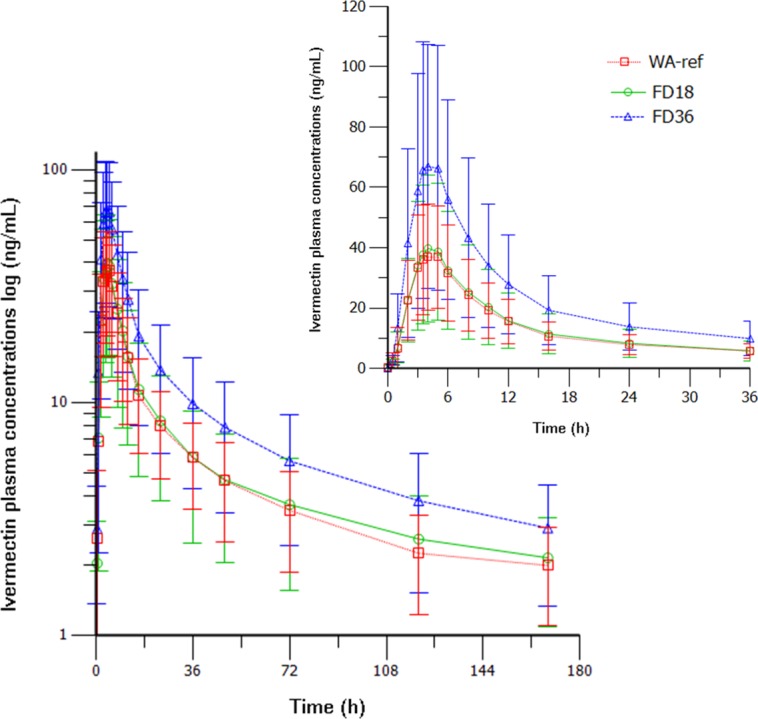
Mean IVM plasma concentration profiles in 54 individuals exposed sequentially in random order to the 3 treatment arms.Insert describe details of the time points within the initial 36 hours. WA-ref: weight adjusted reference group (200 μg/kg), FD18: fixed-dose 18 mg, FD36: fixed-dose 36 mg).